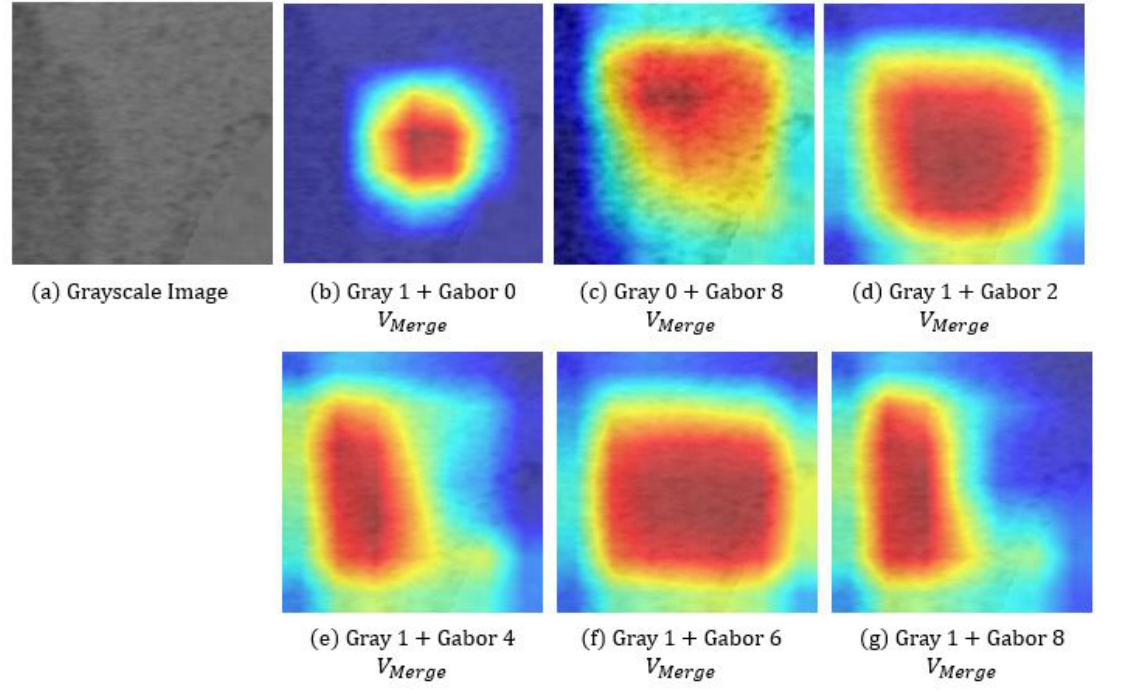
Figure 8. CAM image result for CCM Stain image in a Single-stream